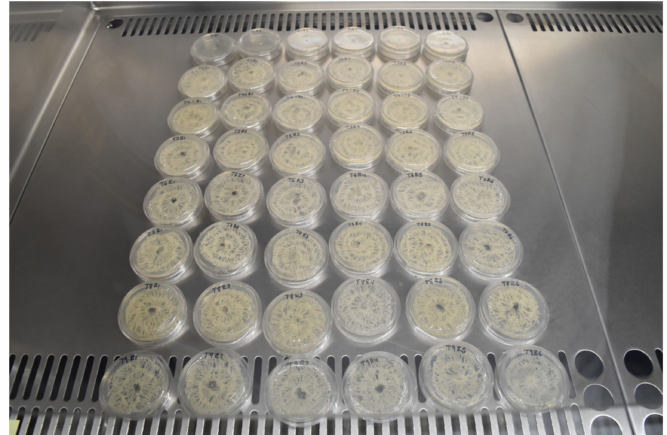
Figure 3. Petri plates containing PDA nutrient agar and net-based PLA/PBA/pine essential oil/chitosan.